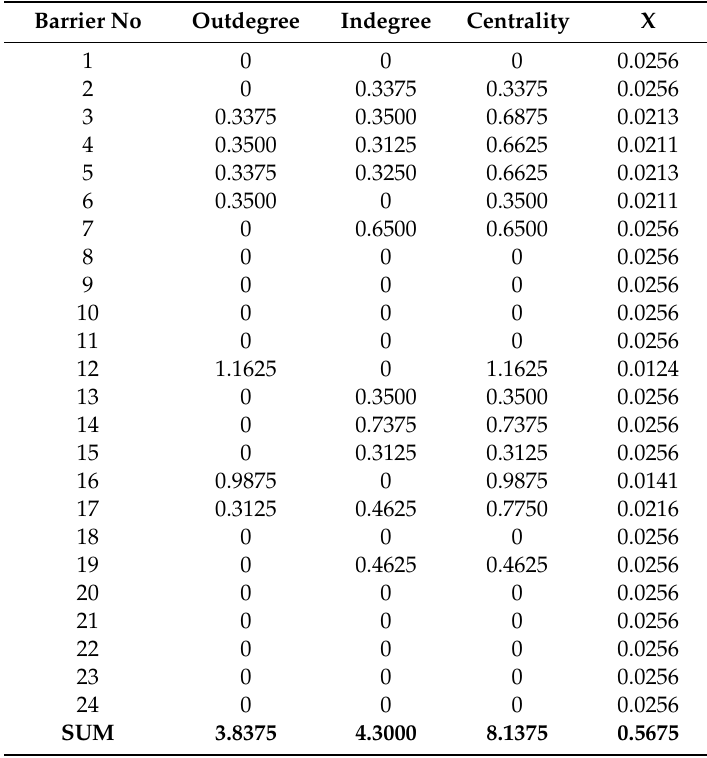
Table 5. FCM Measures